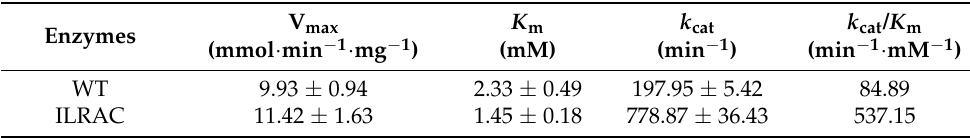
Table 1. Catalytic properties of wild-type and mutant